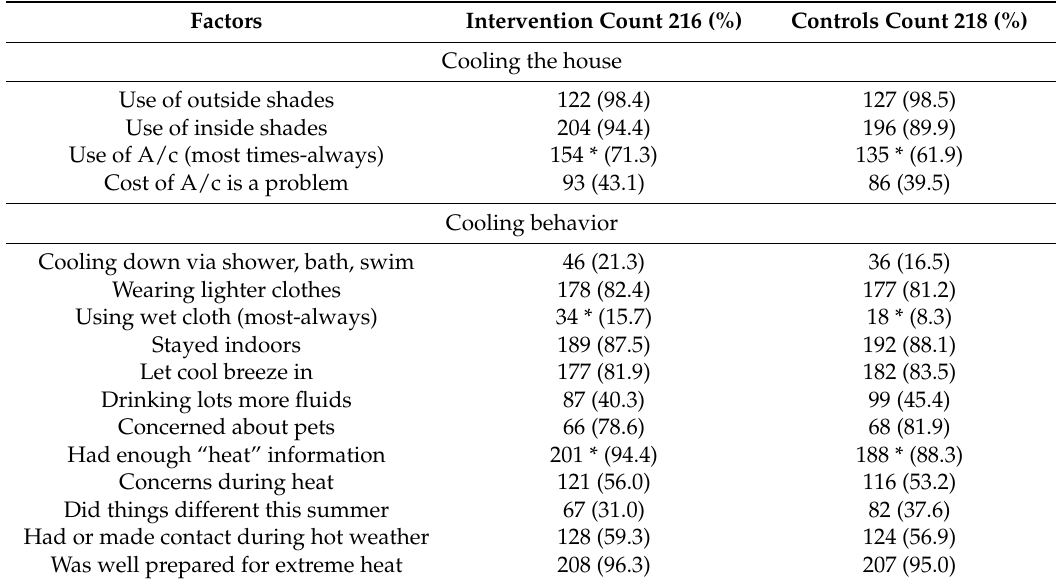
Table 3. Assessment of the frequency distribution of behavior during extreme heat by intervention and control groups.